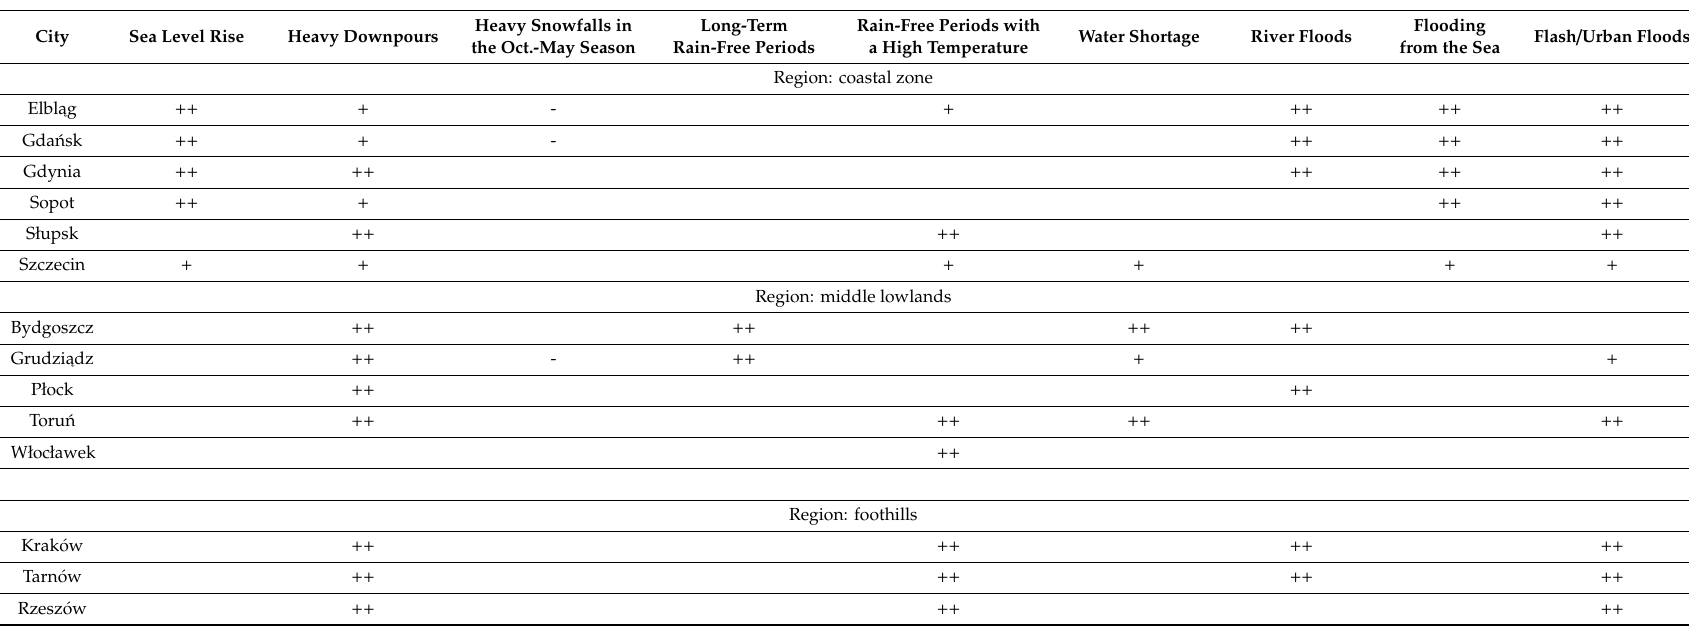
++ high probability of the occurrence, + mid-probability of the occurrence, - a threat of decreasing